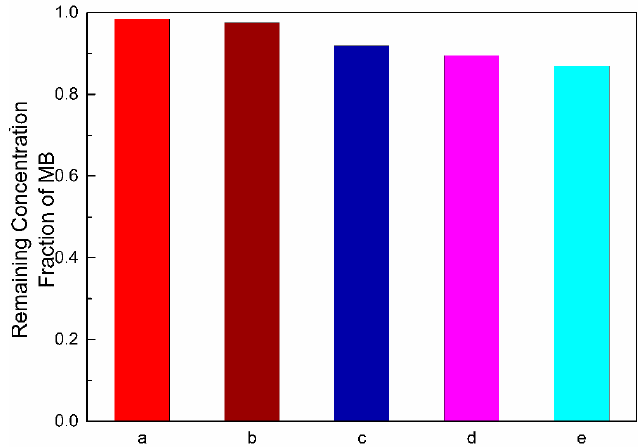
Figure 9. The remaining methylene blue (MB) in solution equilibrated with: ( a ) no catalyst; ( b ) pure WO 3 ; ( c ) WO 3 /GR-0.1; ( d ) WO 3 /GR-0.5; and ( e ) WO 3 /GR-1 after stirring in the dark for 60 min.